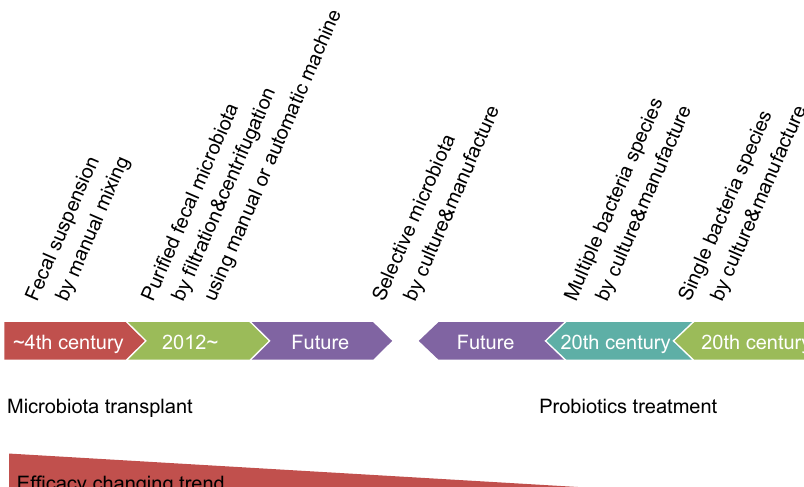
Figure 1. The changing of using microbial cells to treat human